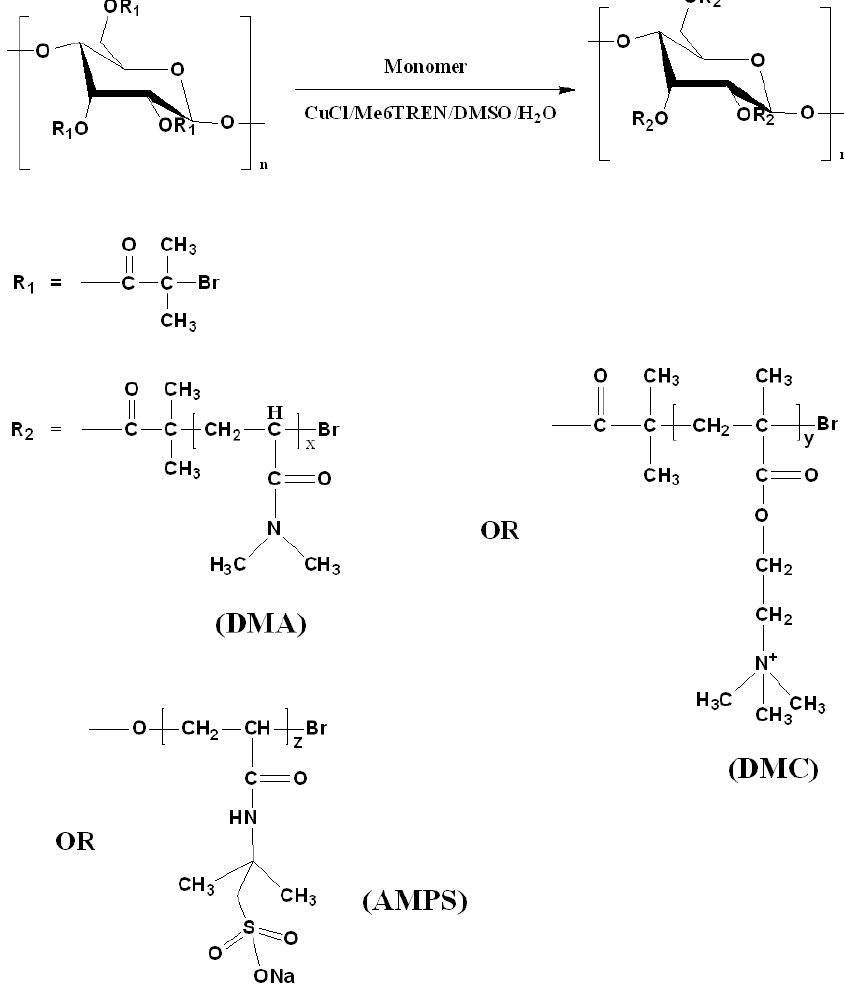
Figure 4. Synthetic route for St ‐ g ‐ Polymer by ATRP.